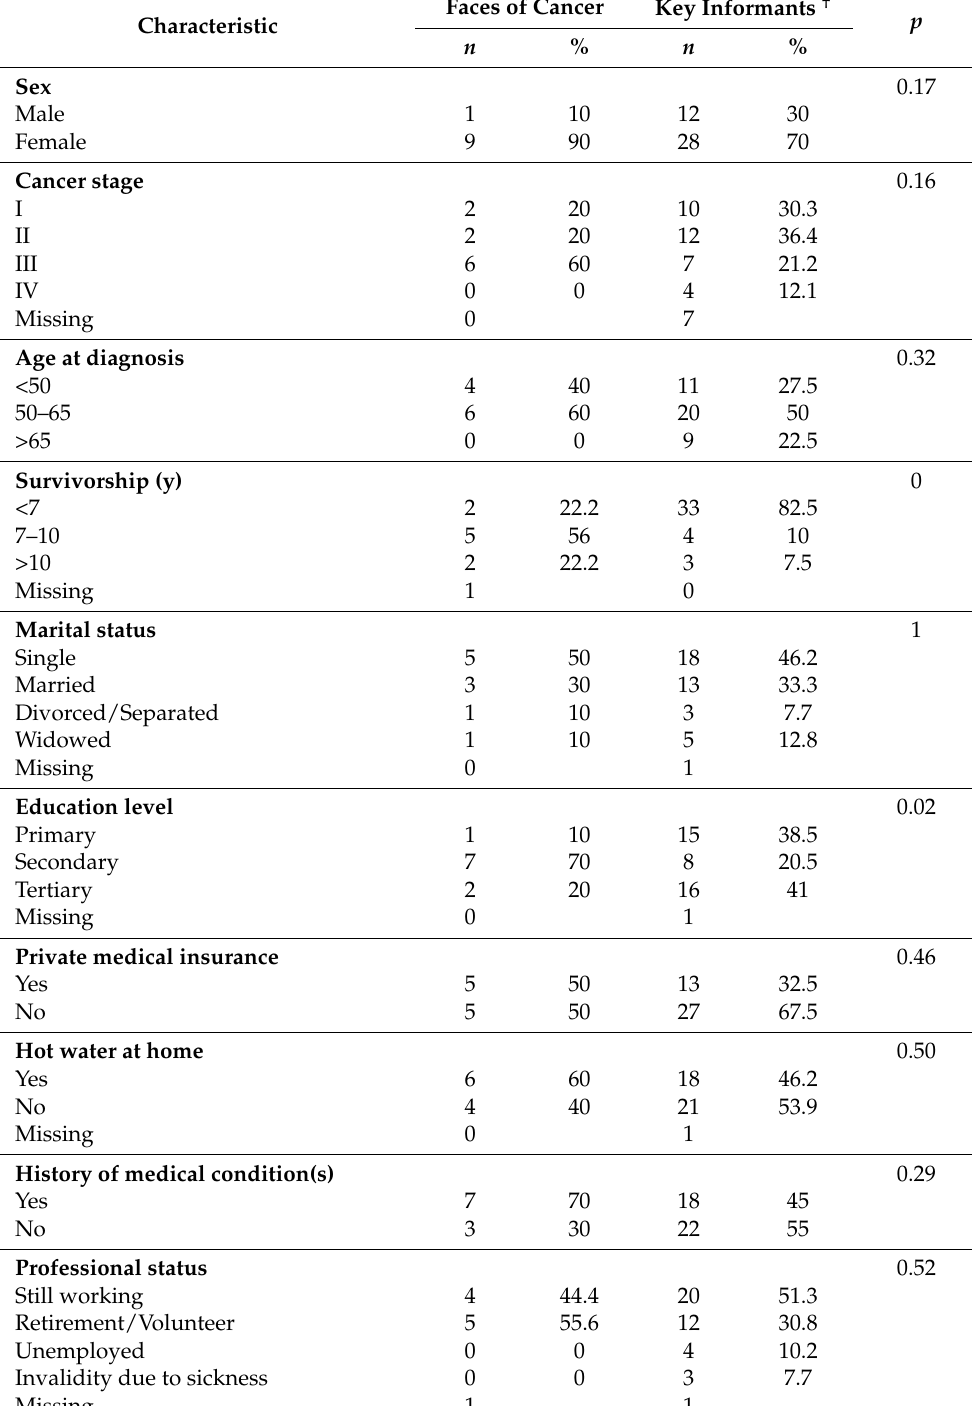
Table 3. Sociodemographic characteristics of cancer survivors and comparison between data sources. Faces of Characteristic